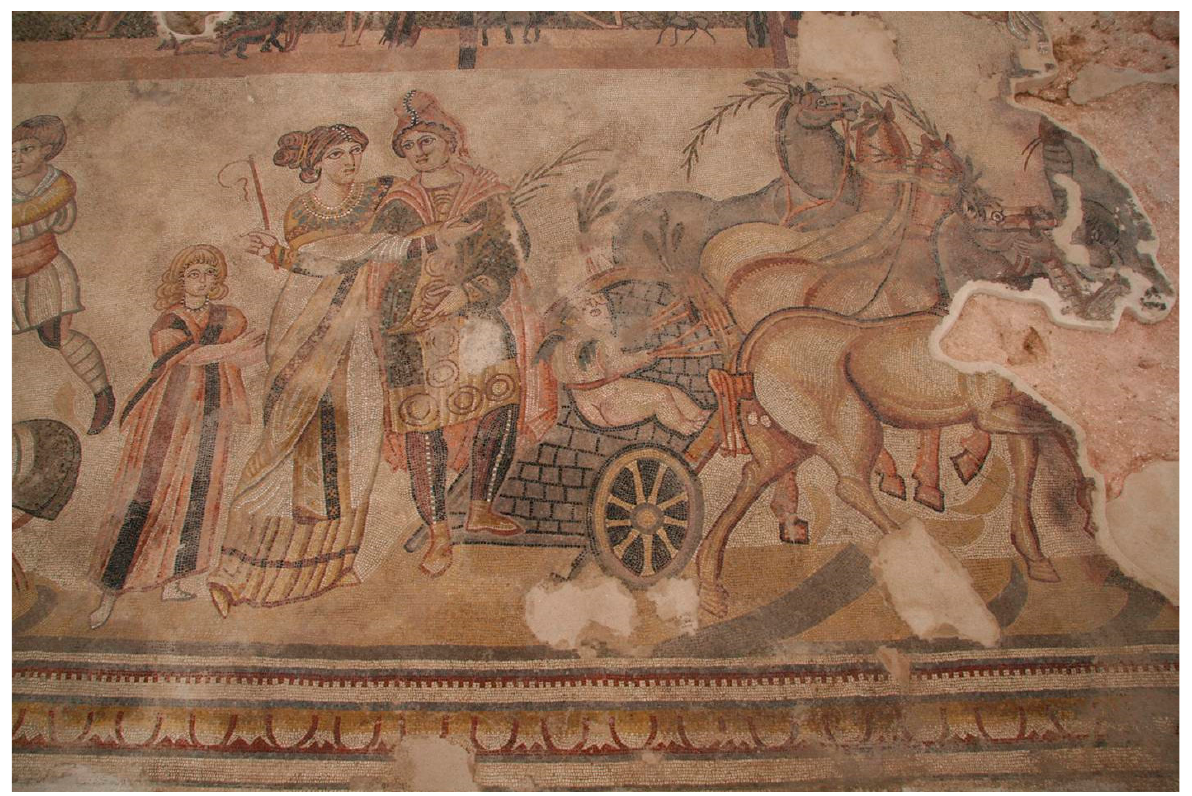
Figure 3. Detail of the embrace between Pelops and Hippodamia. Photo: Miguel Ángel Valero.